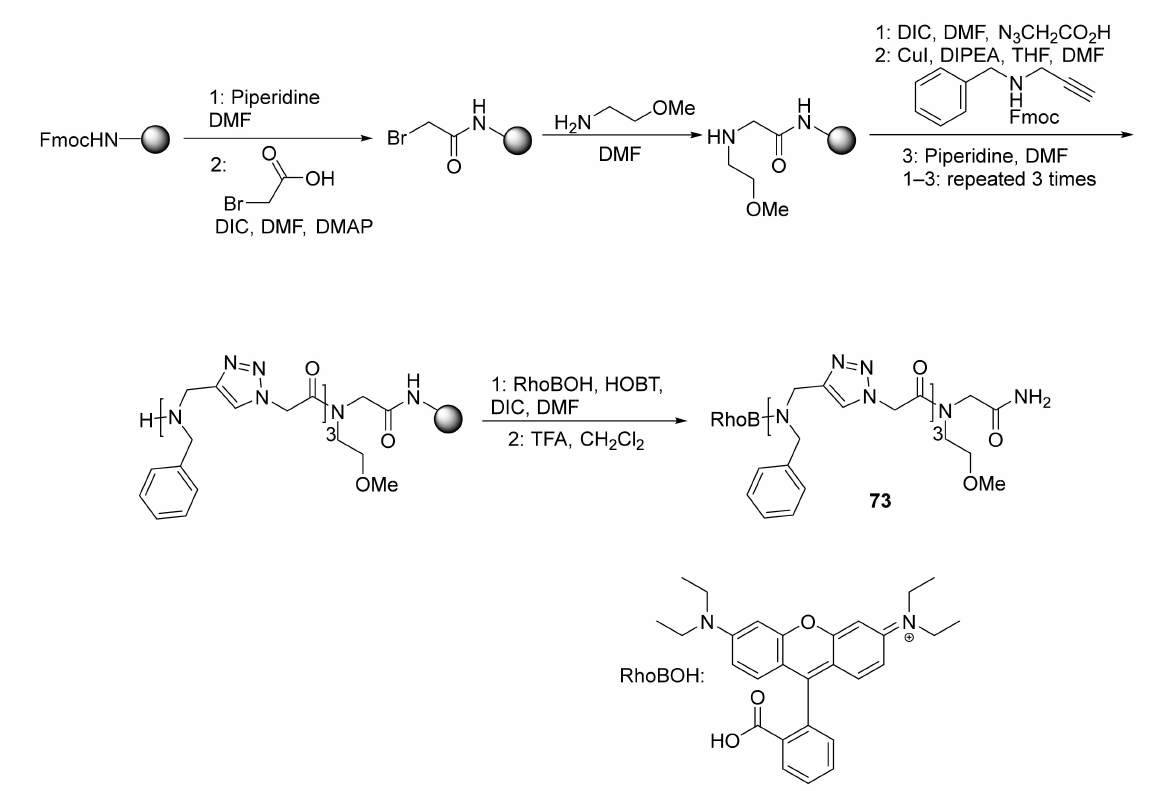
Scheme 10. Example of synthesis of 1,4-triazolopeptoid in solid